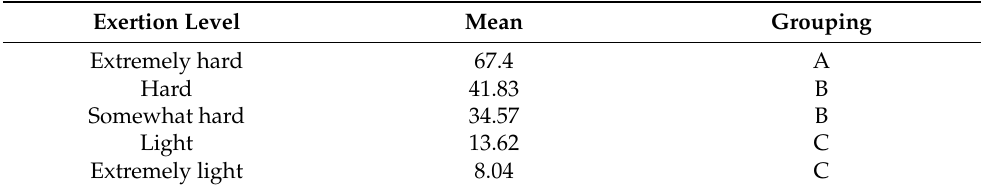
Table 4. Summary statistics for arm forces exerted at different levels of physical exertion (Tukey pairwise comparison at the 95% confidence